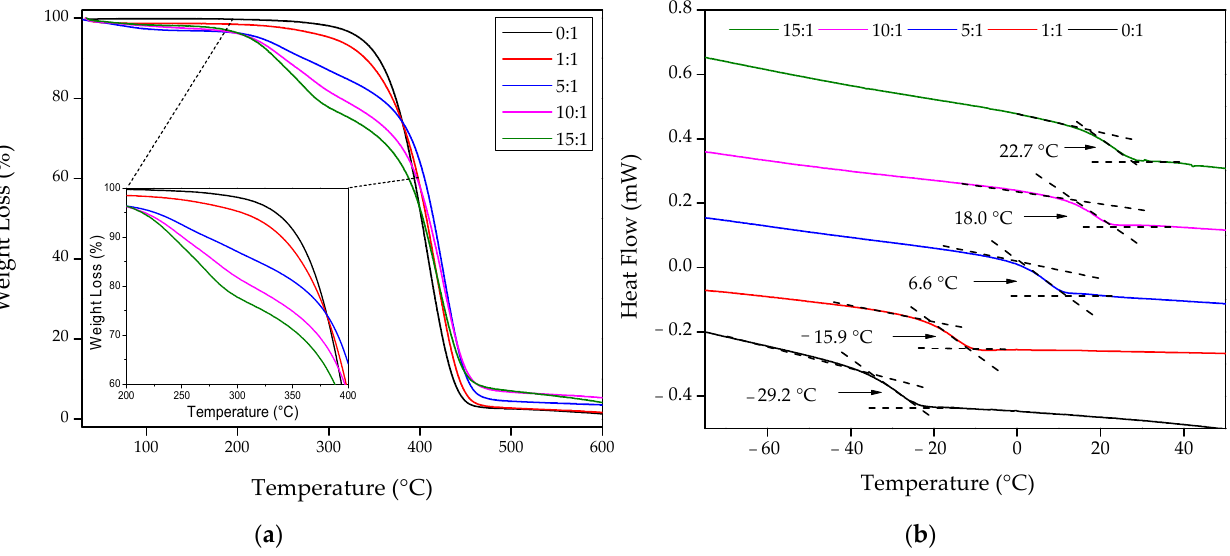
Figure 3. Thermal analysis of the wrinkled hydrogel surfaces with different chemical compositions: ( a ) TGA and ( b ) DSC. Table 3. Thermal studies of the hydrogels net - poly (AAc- co -PEGDA 575 ) at different mole ratios for two temperatures (260 ◦ C and 340 ◦ C), with residual mass at 460 ◦ C, and their respective Tg.